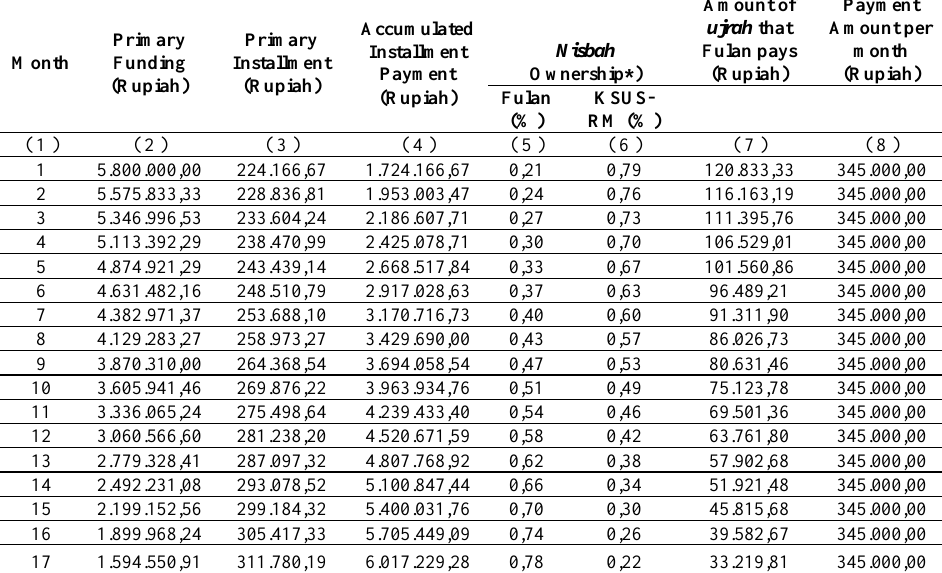
Table 1 Illustration of Al-Ijarah Muntahiya Bi al Tamlik (Financial Lease With Purchase Option) with the same installments per